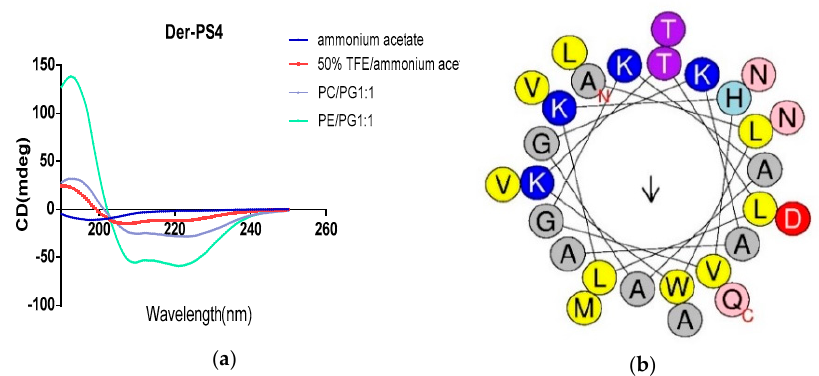
Figure 4. The CD spectra recorded for Der-PS4 in ammonium acetate, 50% TFE/ammonium acetate and membrane mimicking liposomes ( a ). The helical wheel projections of Der-PS4 with an arrow indicated the hydrophobic face ( b ). Table 1. Structural parameters of Der-PS4.